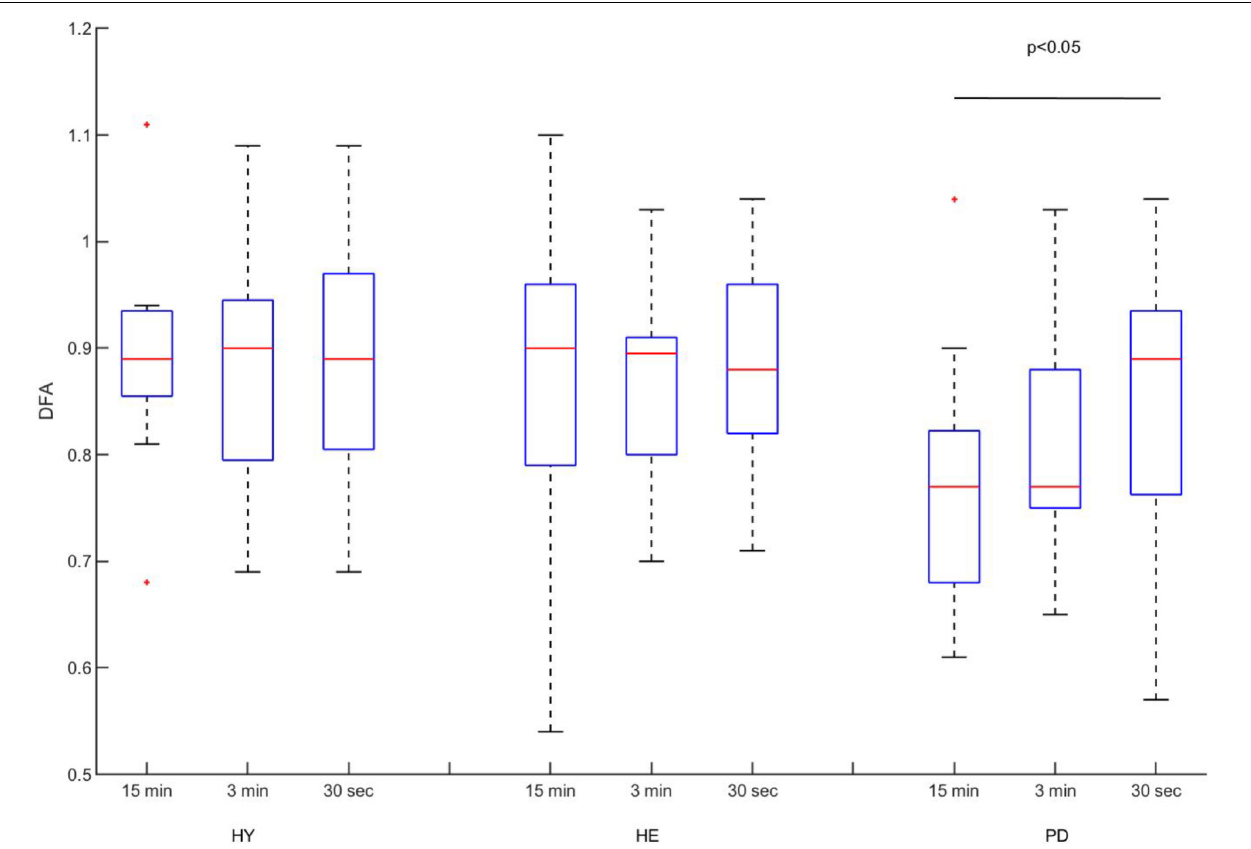
FIGURE 2 | Experimental DFA values. Classical boxplots were used to indicate median, quartiles, and extent of the data (whiskers). Red crosses represent outliers. Results from the two-way ANOVA indicated a significant main effect of group ( p -value reported in the figure). Mean values and standard deviation of mean, coefficient of variation, and DFA can be found in Table 2